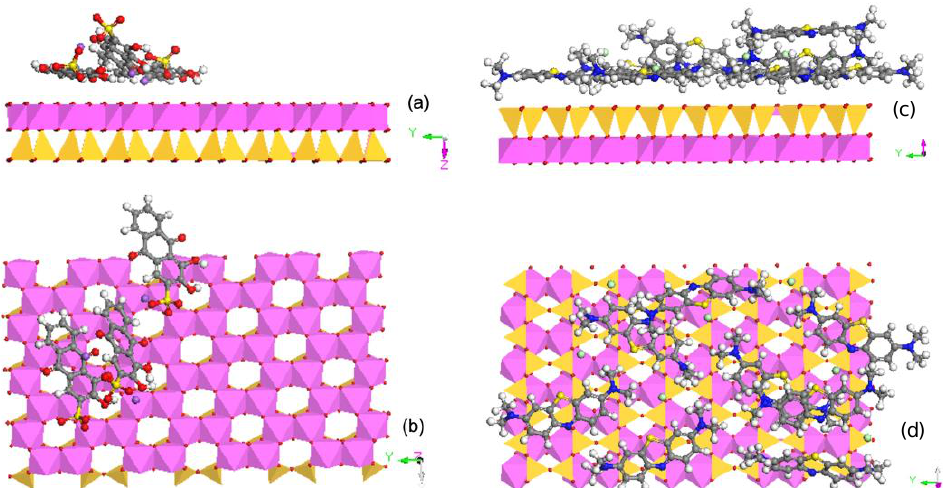
Figure 7. A molecular dynamic simulation showing ARS sorption on an ab plane of the HNC in the presence of counterion Na + projected along the a ( a ) and c ( b ) directions. For ARS, red: O; yellow: S; grey: C; white: H; purple: Na + (Left). MB sorption on the ab plane of the HNC in the presence of counterion Cl − projected along the a ( c ) and c ( d ) directions. For MB, blue: N; yellow: S; grey: C; white: H; green: Cl − (Right).